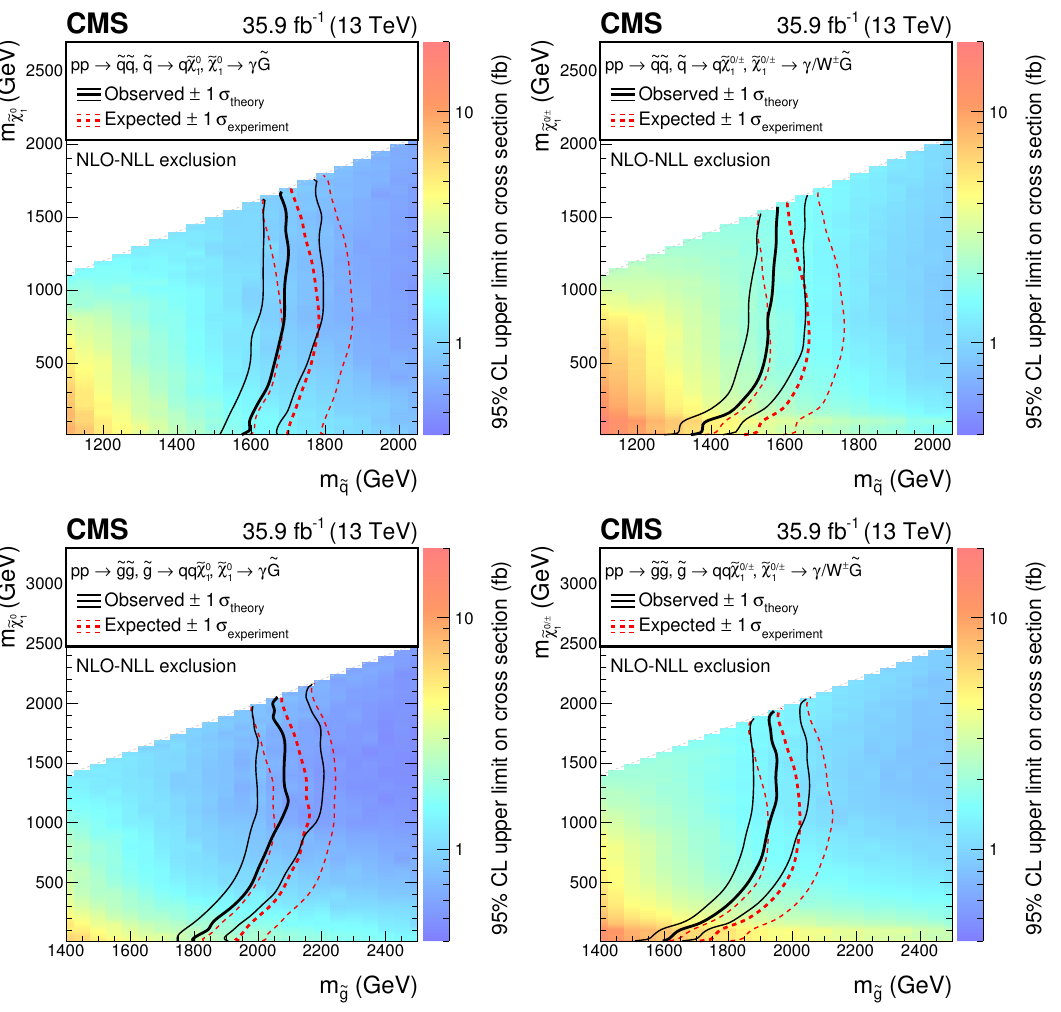
Figure 6 . Exclusion limits at 95% CL for the T6gg (top left), T6Wg (top right), T5gg (bottom left) and T5Wg (bottom right) models. The solid black curve represents the observed exclusion contour and the uncertainty due to the signal cross section. The red dashed curves represent the expected exclusion contours and the experimental